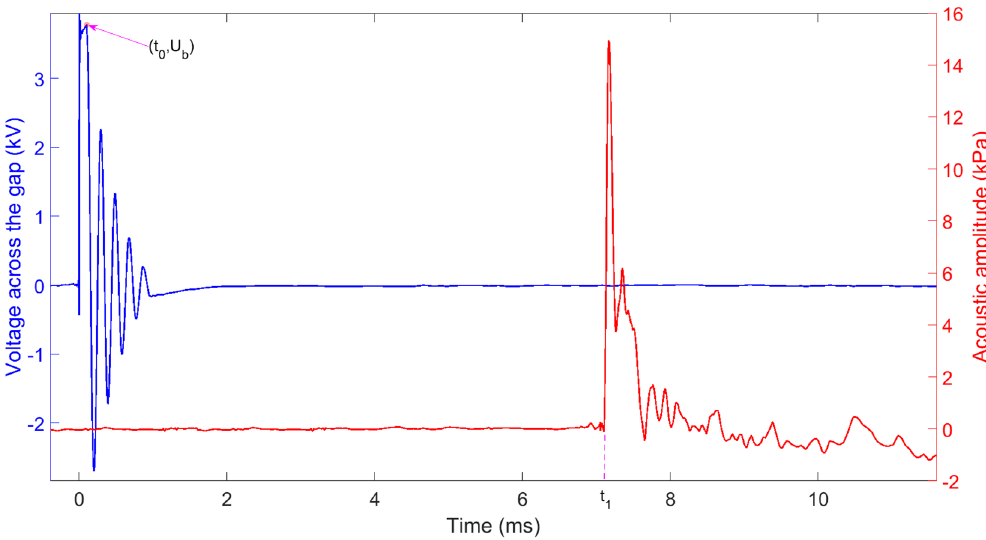
Figure 2. A typical waveform of voltage across the electrode gap of 0.5 mm as well as a subsequent acoustic waveform.